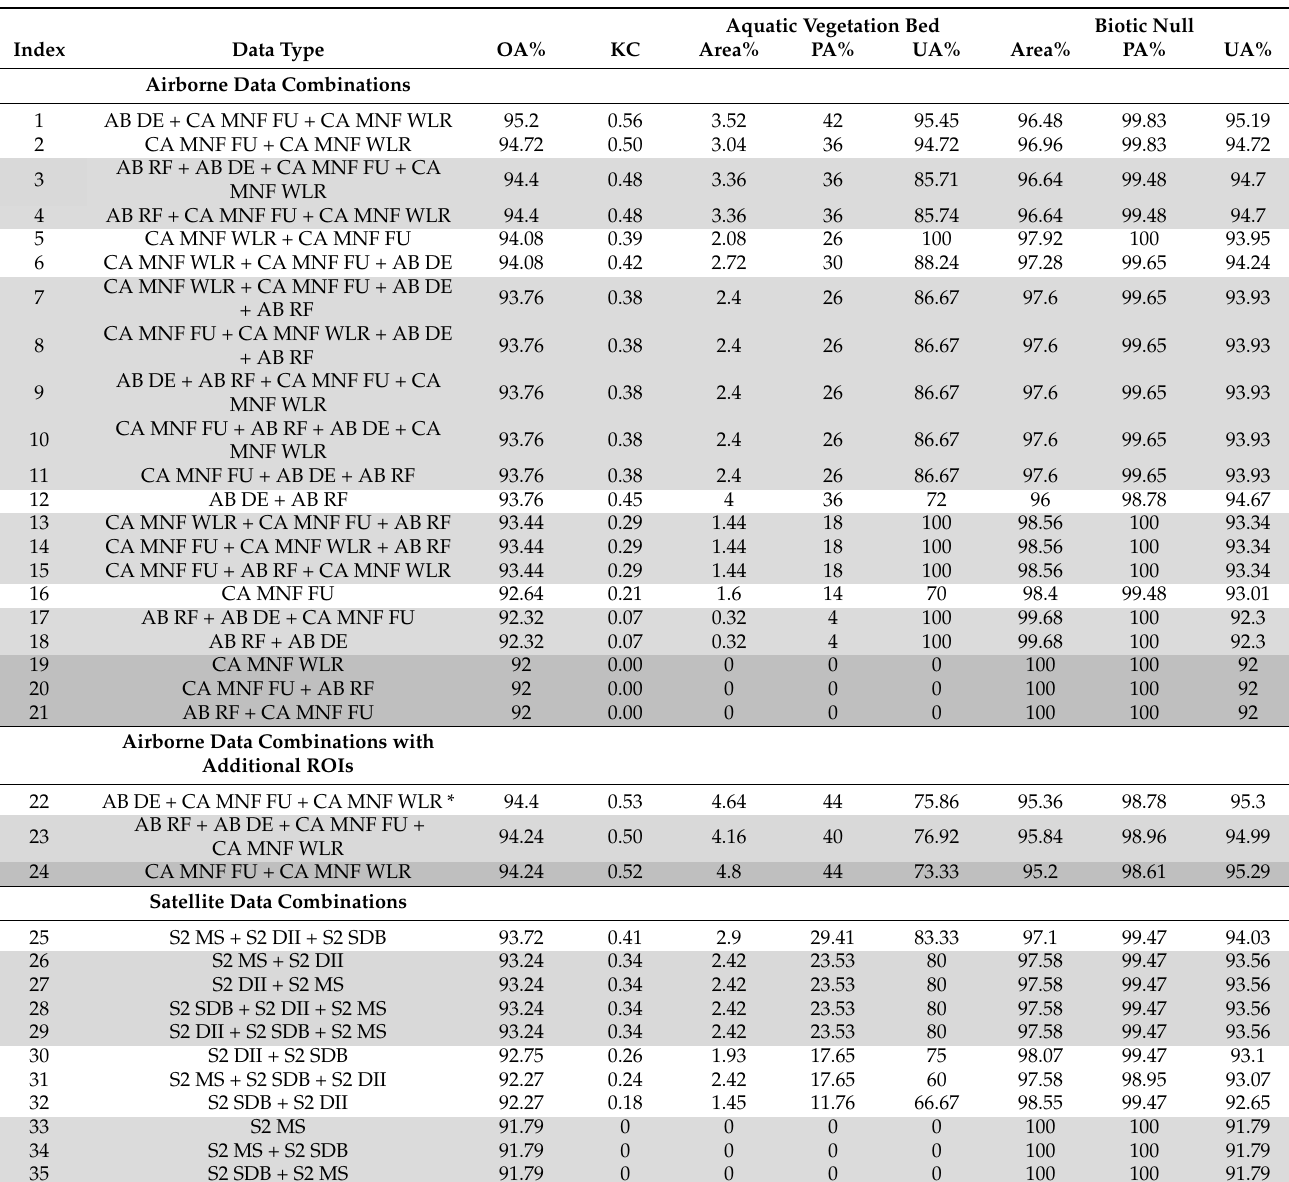
Table A2. Tier 1 biotic component overall and class-specific classification accuracies for airborne and satellite data com- binations. Index = unique numerical value; OA% = percent overall accuracy; KC = Kappa Coefficient; Area% = percent area; PA% = percent producer accuracy; UA% = percent user accuracy. Data combinations are ranked by overall accuracy, highest to lowest, and grouped in which overall accuracy and Kappa Coefficient values are the same (alternating groups of white, light grey and dark grey blocks); there is no particular order of importance within those groups. * Denotes the data combination used for the Tier 2 analysis